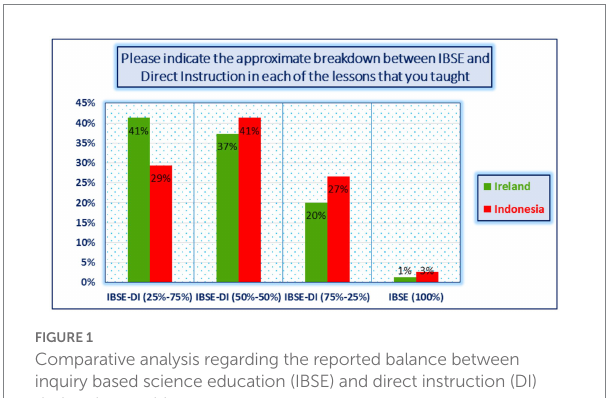
FIGURE 1 Comparative analysis regarding the reported balance between inquiry based science education (IBSE) and direct instruction (DI) during the teaching